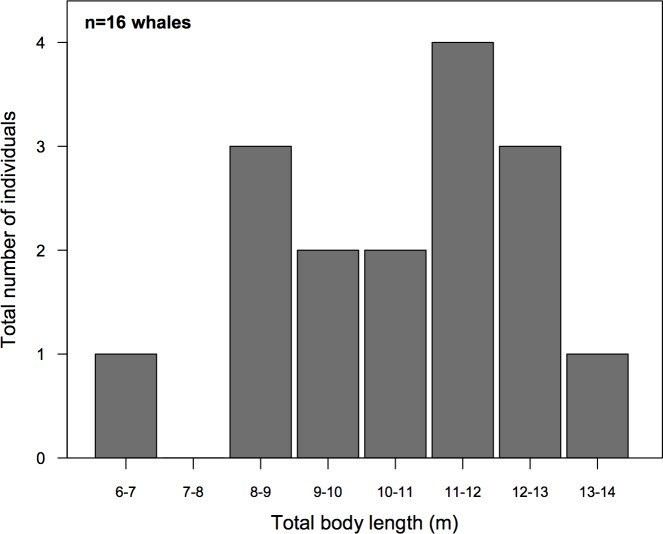
The measured body lengths of 16 unique bowhead whales separated into 8 bins where ~6 m was the minimum size and ~14 m was the maximum.The total body length represents the straight-line distance calculated between the tip of the snout to the fluke notch.